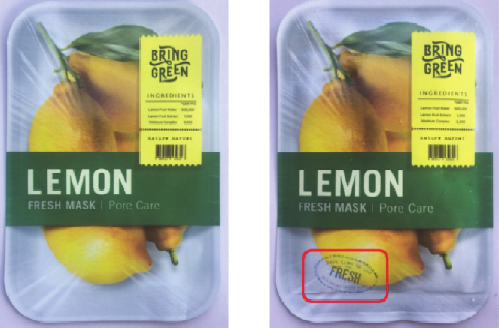
<Figure 9> Temperature Maintenance Technology